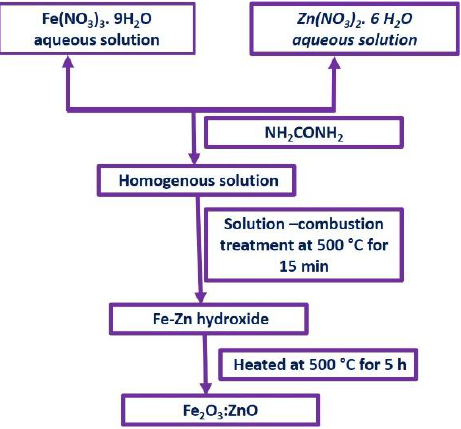
Figure 1. Schematic diagram depicting the formation of the Fe 2 O 3 :ZnO NPs using a combustion technique.